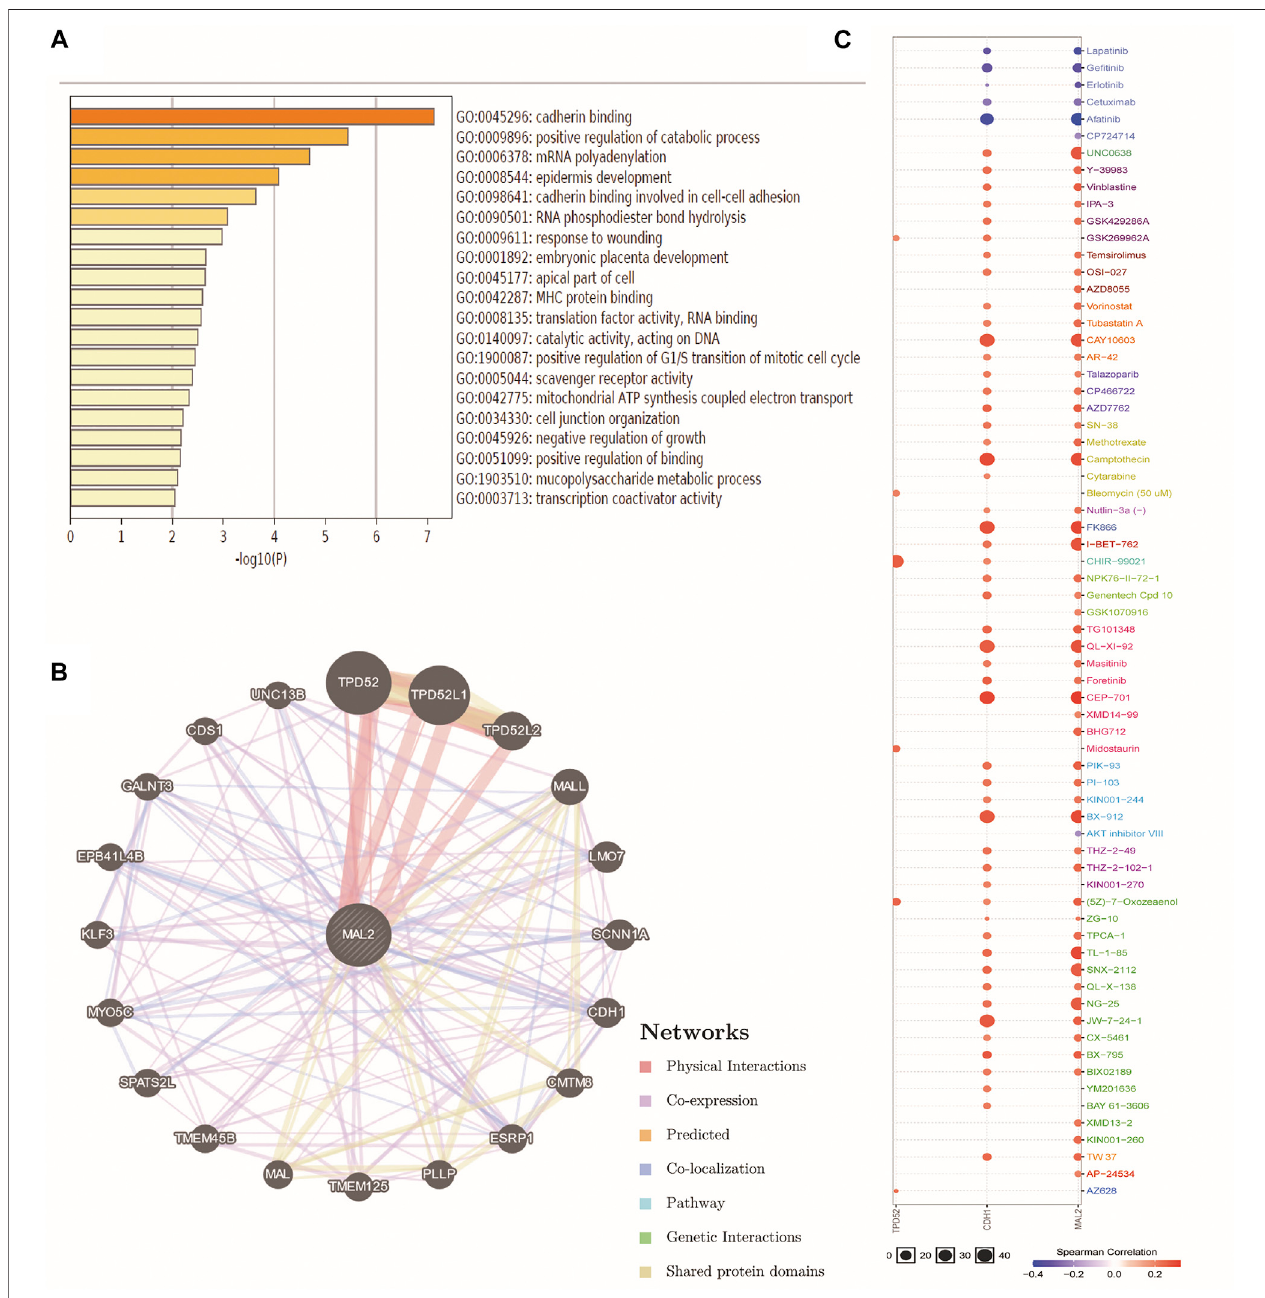
FIGURE 5 | Gene – gene interactionGGI) and drug sensitivity of TPD52, CDH1, and MAL2 in OC. (A) The analysis of GO by SangerBox online platform. (B) The network for MAL2 and the 20 most frequently altered neighbor genes by GeneMANIA. (C) Drug sensitivity analysis of TPD52, CDH1, and MAL2 in OC patients by the GSCALite online tool. The positive correlation means that a high expression of TPD52, CDH1, and MAL2 is resistant to the drugs.